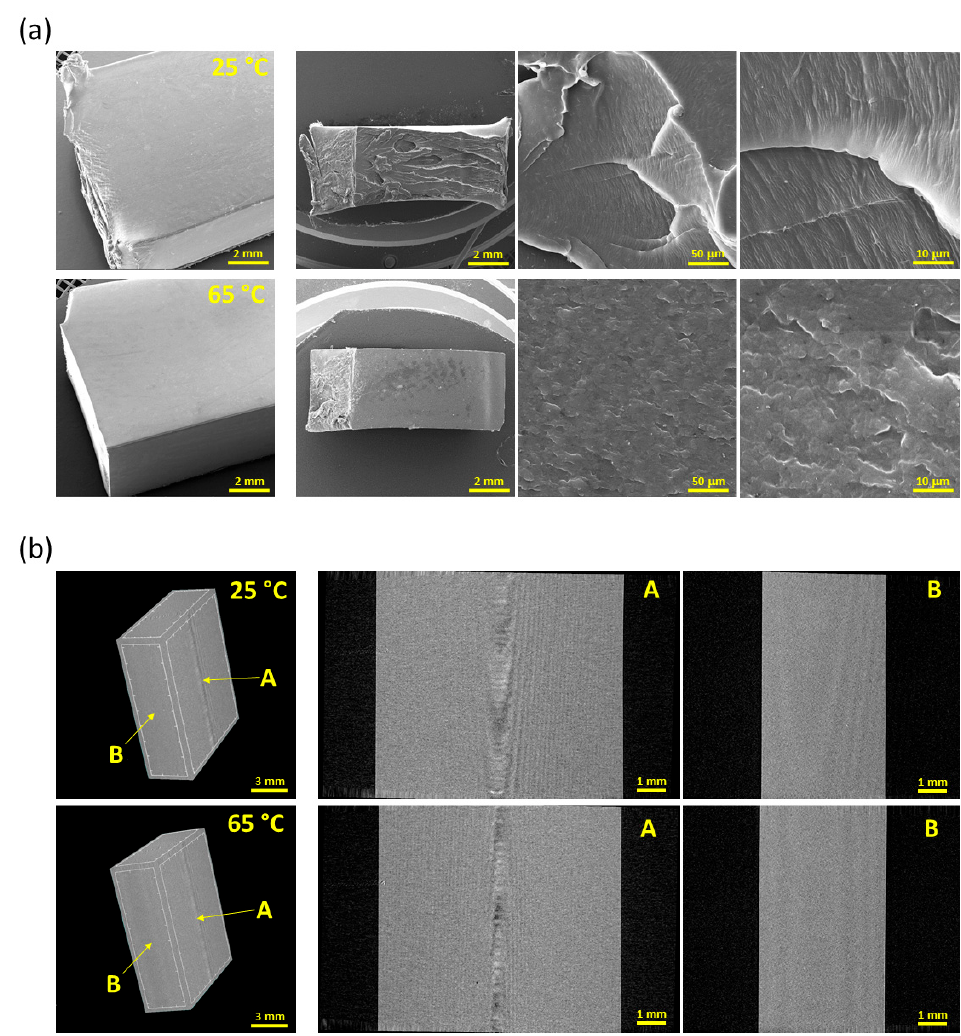
Figure 4. Morphology characterization imaging: SEM images showing the surface morphology of the samples on the left and the fracture morphology following the Charpy impact test at various magnifications on the right − ( a ) and CT images showing a 3D preview of a scanned sample with the scanning directions marked on the left and images showing sections of the internal structure from two sides (views from direction A and B) perpendicular to each other on the right − ( b ).